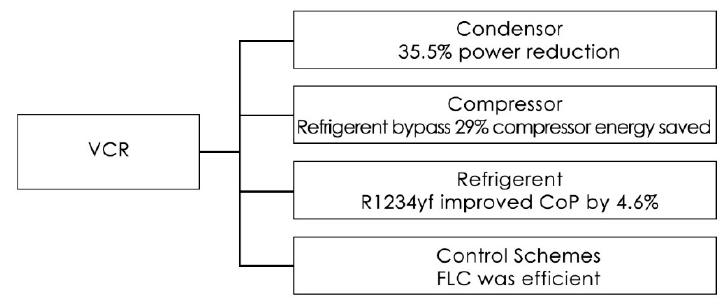
Figure 9. Impact of optimized parts in a VCR system.